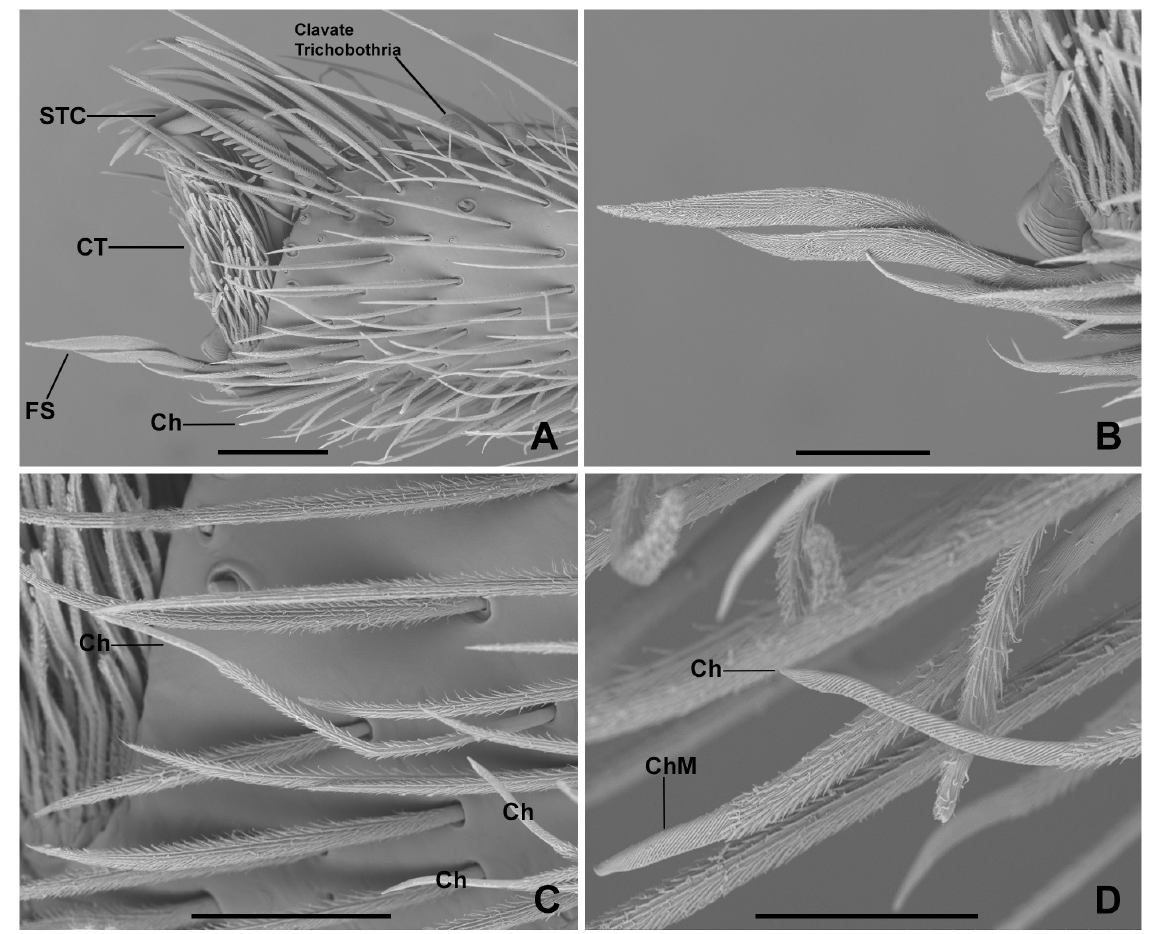
Fig. 6. SEM micrographs of Ammonius pupulus Thorell, 1899, ♂ (RMCA 169417), tarsus I. A . Lateral view. B . Detail of frictional setae, lateral view. C–D . Detail of the chemosensory setae. Abbreviations: Ch = chemosensory setae; ChM = chemosensory setae male; CT = claw tufts; FS = frictional setae; STC = superior tarsal claws. Scale bars: A = 100 µm; B–C = 50 µm; D = 30